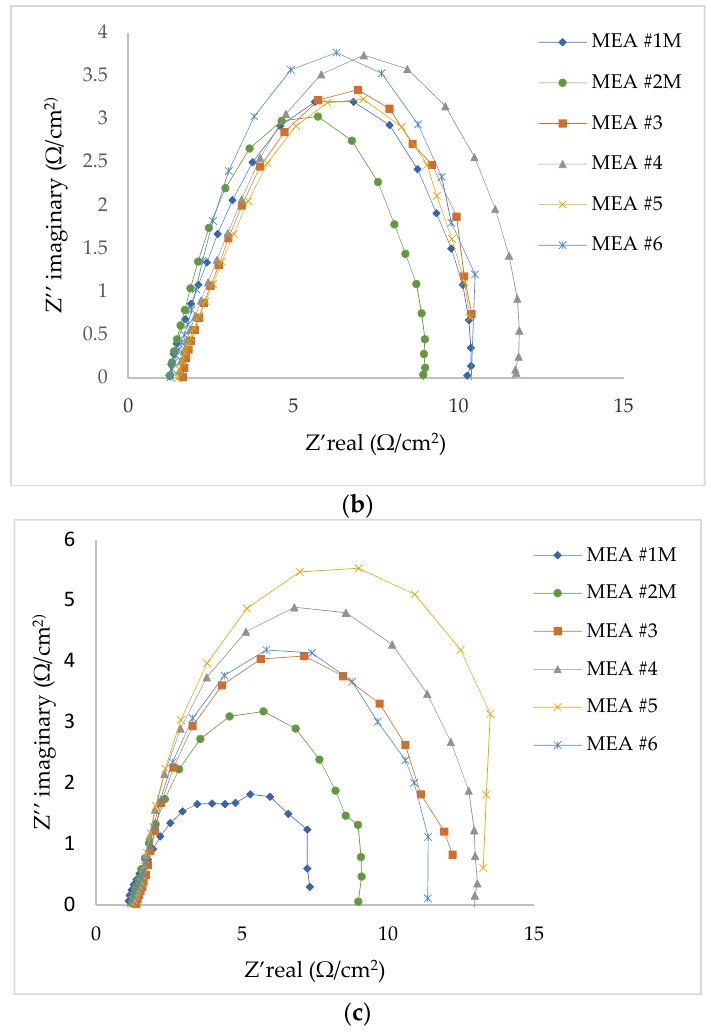
Figure 4. Nyquist plots of benchmark monolayer MEA (MEA #1M) and reduced Pt loading MEAs (MEA #2M- #6), under ( a ) 20%, ( b ) 60%, and ( c ) 100% RH. The Nyquist plots were fitted with a Randles equivalent circuit model [28] and the results are shown in Table 4. R1 represents the ohmic resistance and the charge transfer resistance is given by R2. Table 4. The EIS fitting parameters obtained from the Randles equivalent circuit model.